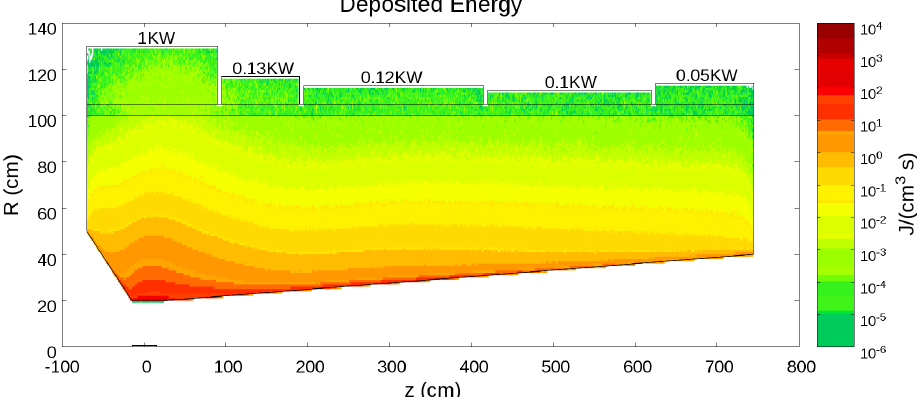
FIG. 11. Heat deposition in the shielding block and the SC